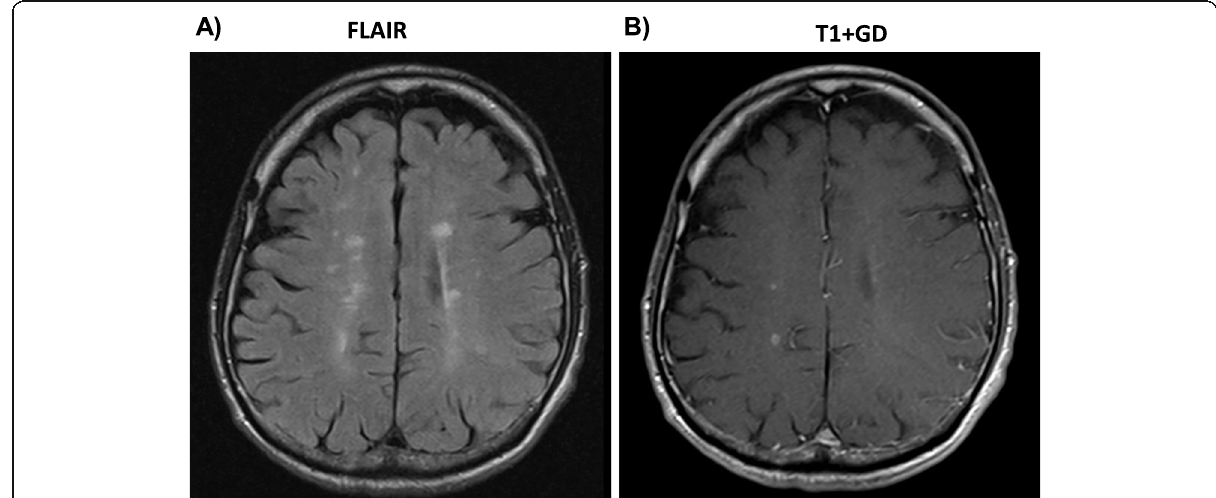
Fig. 4 MRI imaging of patient 2 displaying disease activity. a FLAIR and b T1 weighted MRI with application of gadolinium at day 300 after start of ATRA revealed multiple gadolinium-enhancing lesions